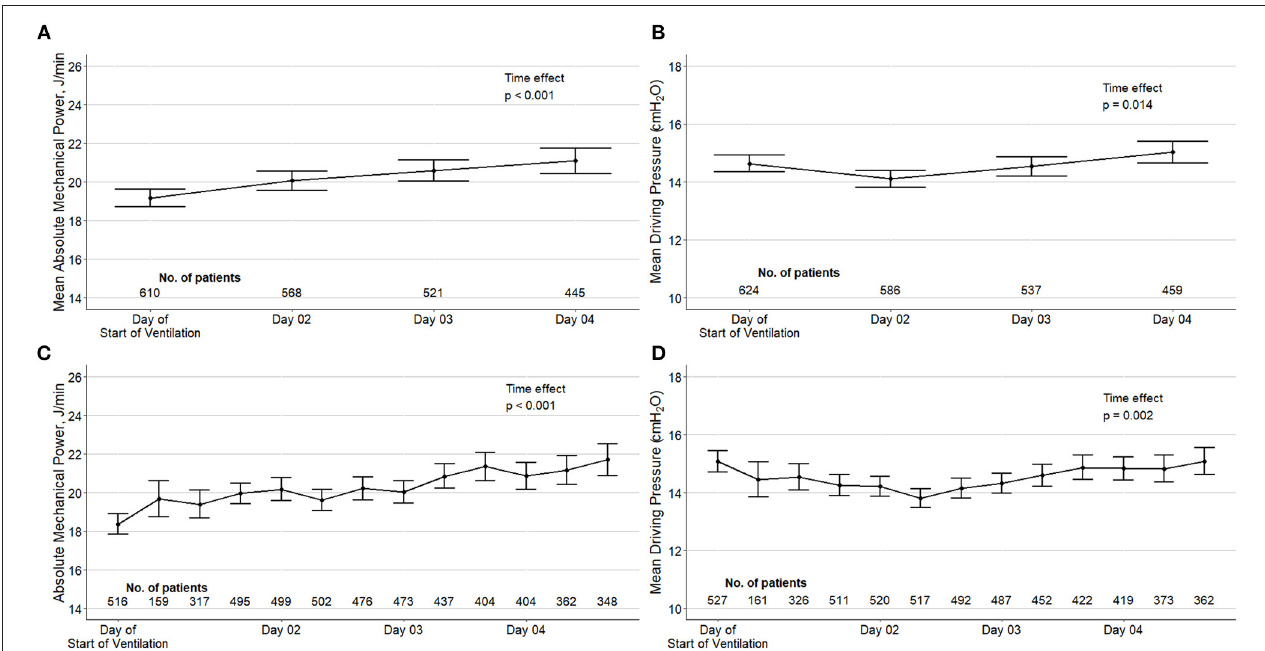
FIGURE 1 | Driving pressure and mechanical power over the first four days of ventilation in the included patients. Top panels (A, B) : mean daily values of 1 P and MP according to a maximum of four measurements in the day of start of ventilation and three measurements in the next days. Bottom panels (C, D) : 1 P and MP per time point of assessment. Circles are means and error bars are 95% confidence intervals. Both variables were calculated using only measurements without spontaneous breathing activity. P values from a mixed-effect model with time as fixed effect (as continuous variable) and patients as random effect to account for repeated